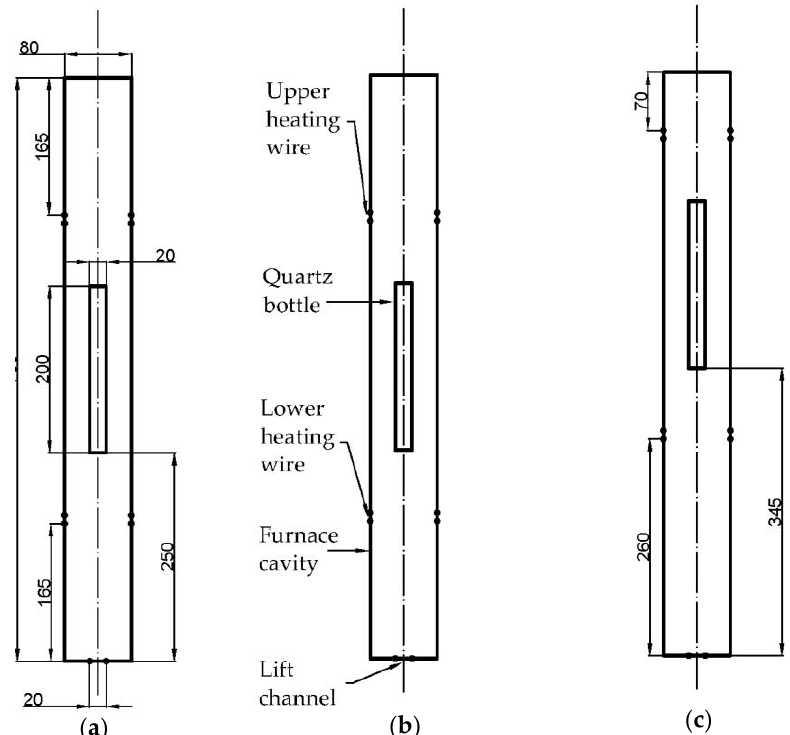
Figure 1. Geometric model of Bridgman growth system: ( a ) process A: upper heating wire 501 K, lower heating wire 460 K; ( b ) process B: upper heating wire 501 K, lower heating wire 480 K; ( c ) process C: upper heating wire 501 K, lower heating wire 480